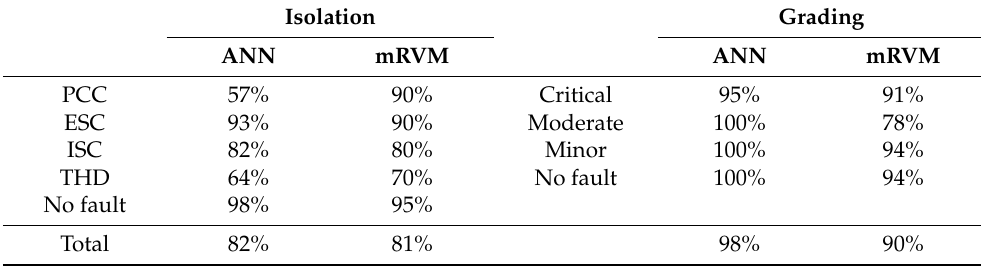
Table 4. Statistics of diagnosis performance (success rate %) with the ANN and mRVM